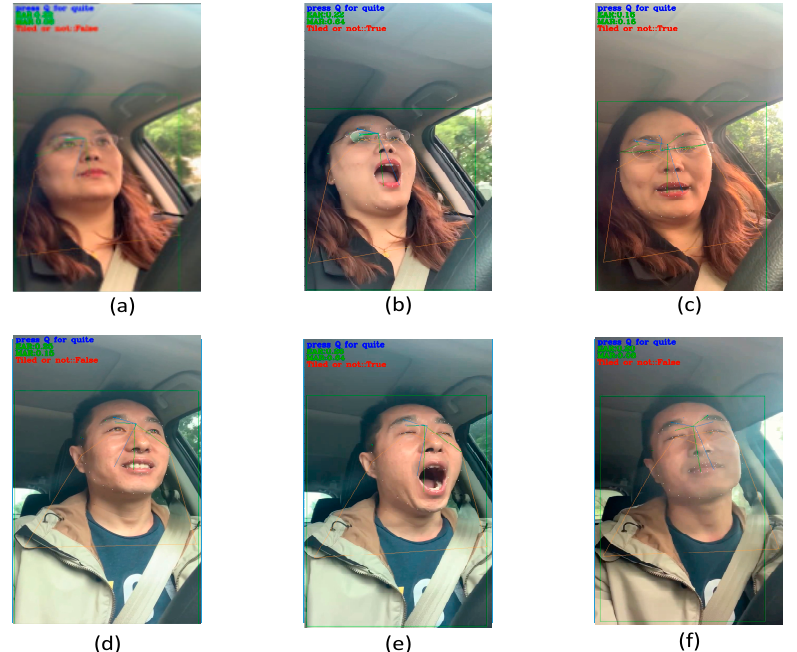
Figure 12. The effect of the original detection method on the actual scene. ( a ) Female normal driving; ( b ) Female driver yawning; ( c ) Female drivers close their eyes; ( d ) Male normal driving; ( e ) Male driver yawning; ( f ) Male drivers close their